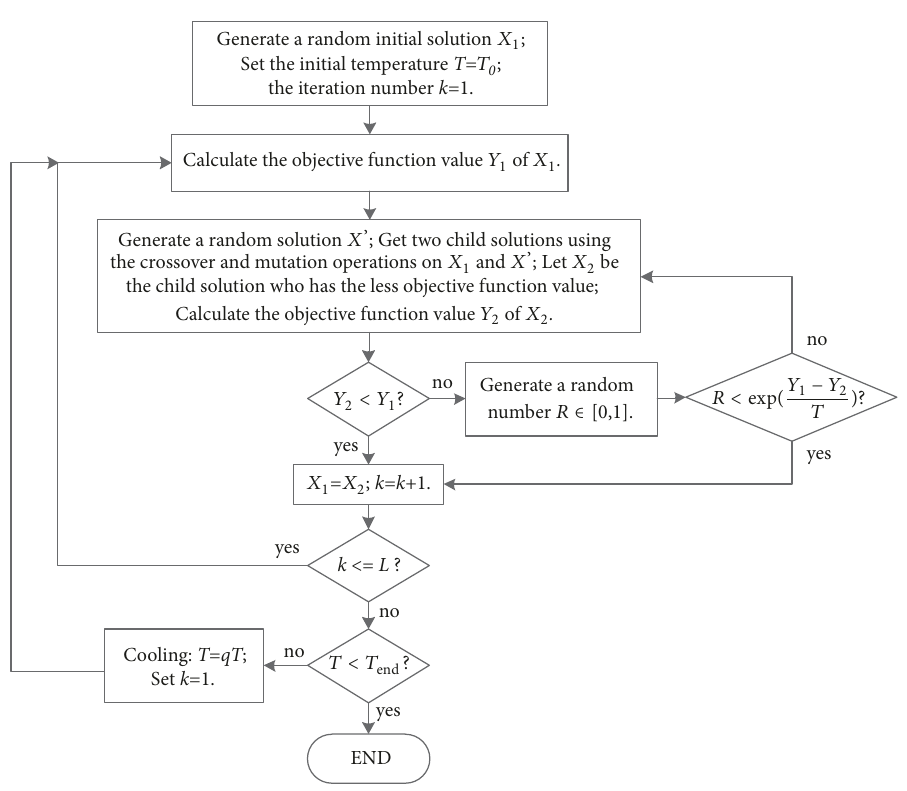
Figure 7: Flowchart of